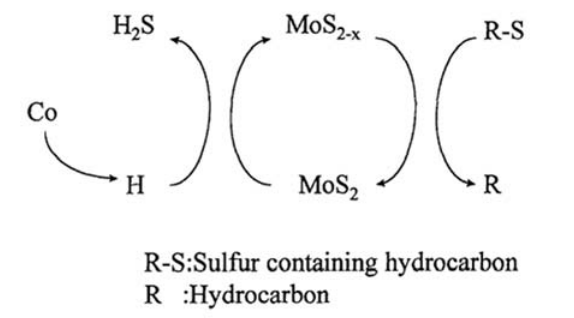
Figure 8. Scheme for the role of cobalt on HDS reaction . Reproduced from reference [102] with permission from